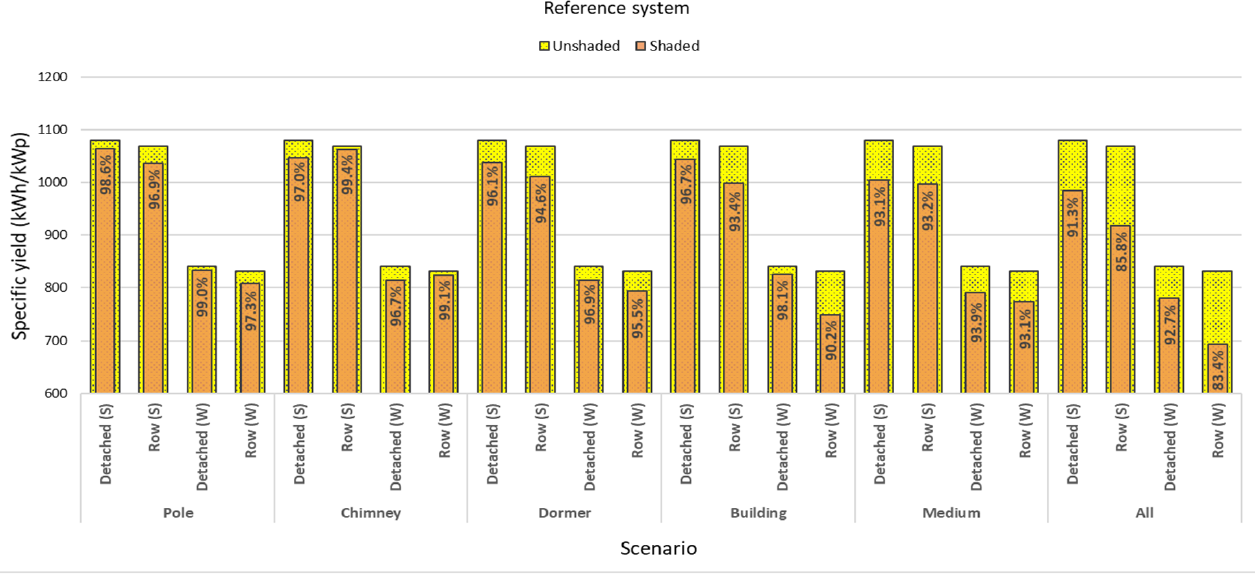
Figure 15. Specific yield and losses compared to unshaded scenarios for the reference system, for two azimuth directions (South, West).